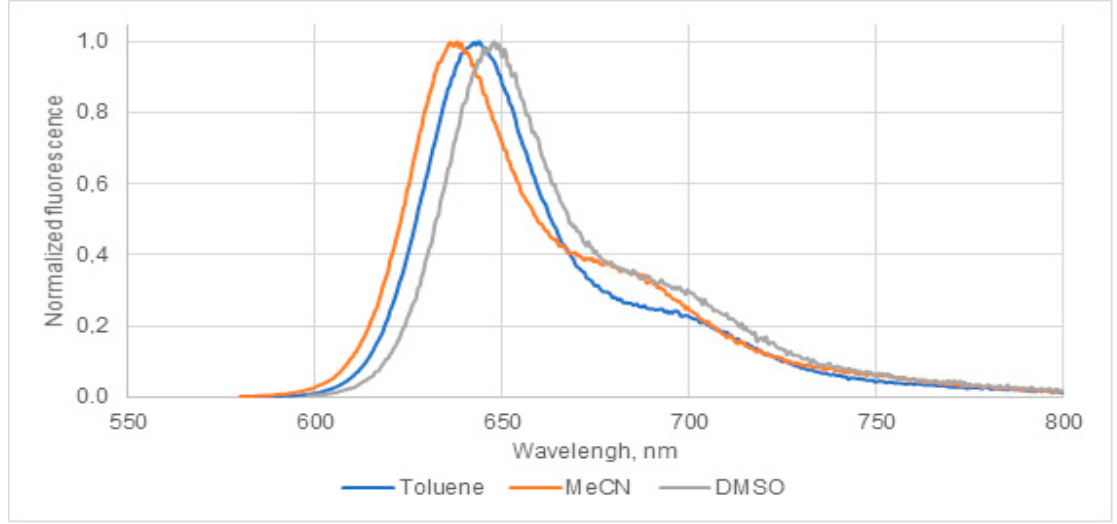
Figure 1. The electronic absorption and fluorescence spectra of BODIPY 1 . Table 1. Spectroscopic and photophysical characteristics of BODIPY 1 at 22 °C.